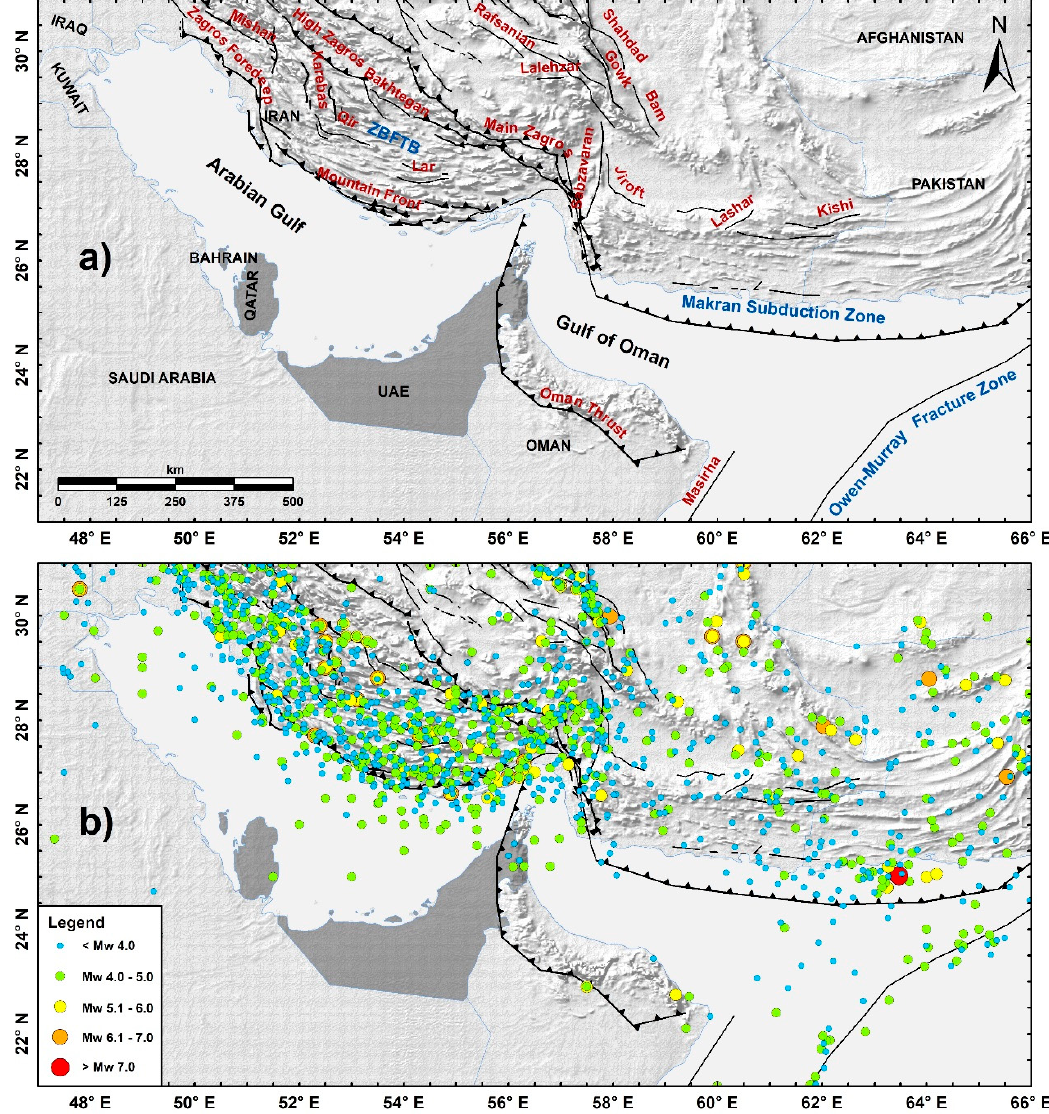
Figure 1. Regional tectonic setting ( a ), and shallow and intermediate-depth Poissonian earthquakes (since 658 to 2019) for the surroundings of UAE, Qatar and Bahrain ( b ) [2,6]. Earthquake sizes have been drawn relative to the moment magnitude.